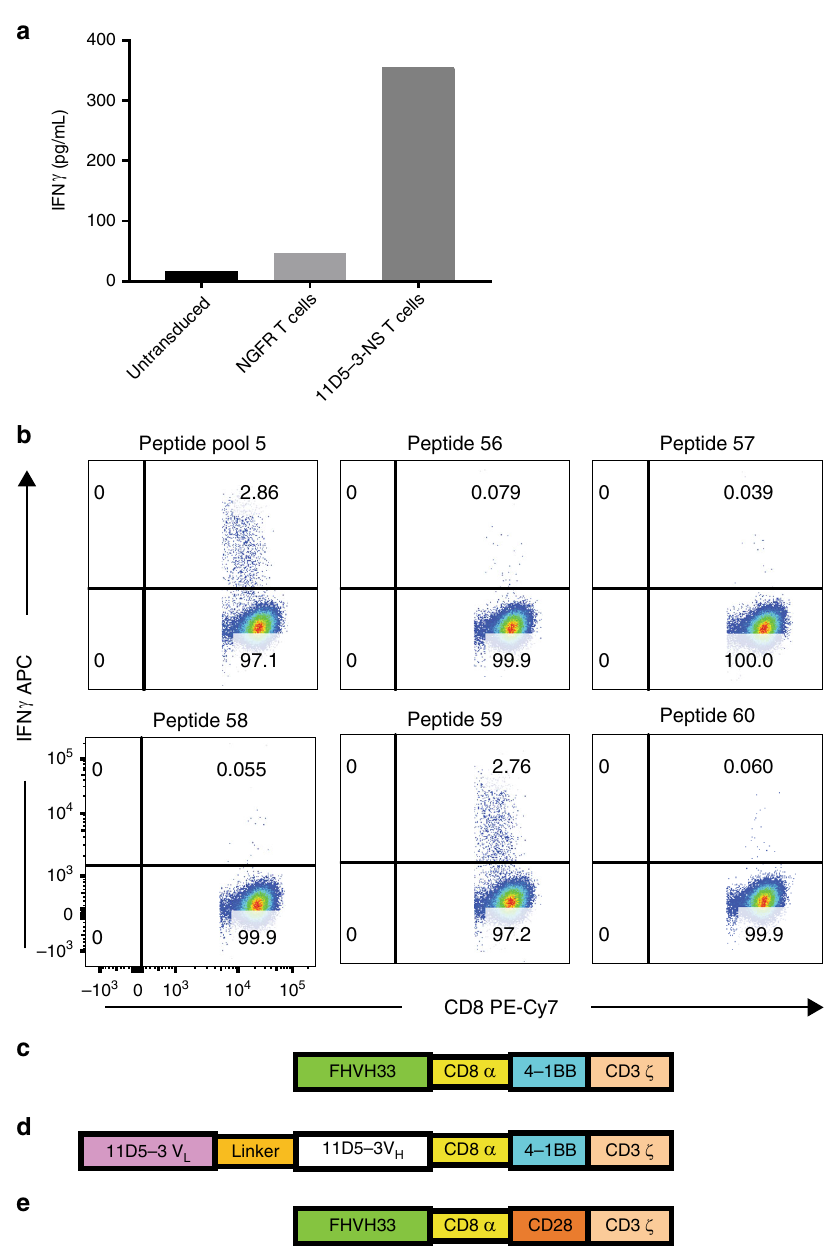
Fig. 1 A murine anti-BCMA CAR can be immunogenic. a 11D5-3-NS, a truncated nonsignaling CAR containing only the murine 11D5-3 scFv, hinge, and transmembrane regions was designed. Irradiated, autologous 11D5-3-NS-transduced T cells were used to stimulate PBMC in culture. PBMC were from a patient who received 11D5-3-CD828Z CAR T cells on a clinical trial. Seven days later, the PBMC were stimulated again with 11D5-3-NS-transduced T cells. Seven days after the second stimulation, the PBMC were cultured overnight with autologous T cells that were either untransduced, transduced with the human NGFR gene, or transduced with the 11D5-3-NS gene. Culture supernatants were assayed for IFN γ by ELISA. 11D5-3-NS-speci fi c release of IFN γ was found. b PBMC collected after CAR T-cell infusion to a different patient than in a were stimulated with autologous 11D5-3-CD828Z CAR + T cells as in a . Peptide reactivity was assessed by culturing the stimulated PBMC for 6 h with autologous dendritic cells pulsed with 15-mer peptides of a peptide library covering all possible 15 mers of the 11D5-3 scFv. Speci fi c IFN γ production by T cells was found in an ICCS assay against peptide pool 5 and peptide 59 from pool 5. c A diagram of the FHVH33-CD8BBZ CAR with the fully human heavy-chain binding domain FHVH33, hinge and transmembrane domains from human CD8 α , a human 4-1BB domain, and a human CD3 ζ domain. d 11D5-3-CD8BBZ has a murine scFv binding domain. Otherwise, 11D5-3-CD8BBZ has an identical sequence as FHVH33-CD8BBZ. e Except for substitution of CD28 for 4-1BB, FHVH33-CD828Z is identical to